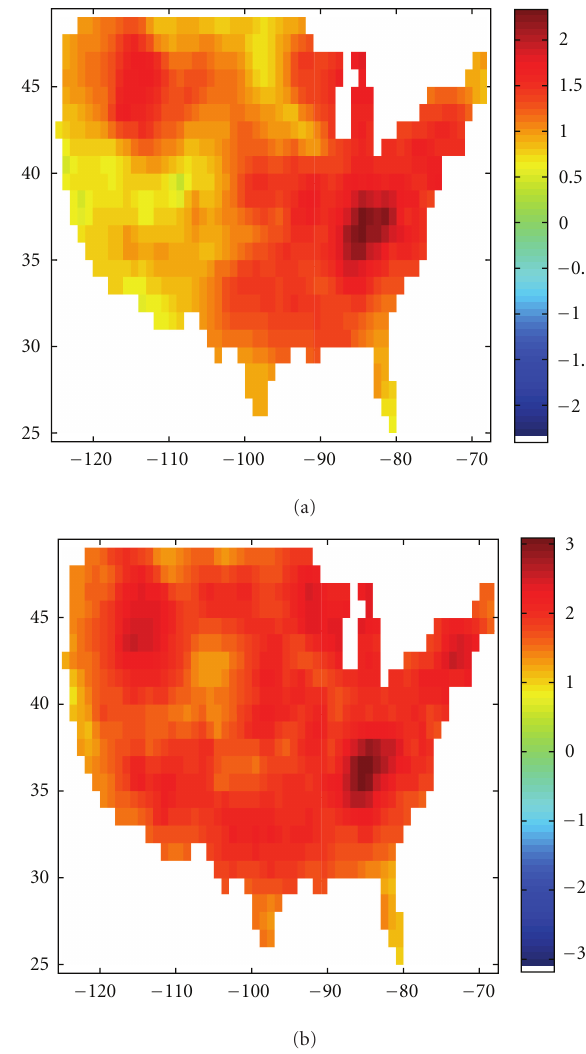
Figure 5: (a) Gridded annual minimum temperature trend as that of 2011-2012, relative to the 1976–2005 mean, over the coterminous USA. (b) Change in trend annual minimum temperature between 1970-1971 and 2011-2012. Units are K; pointwise 1- σ uncertainties are around